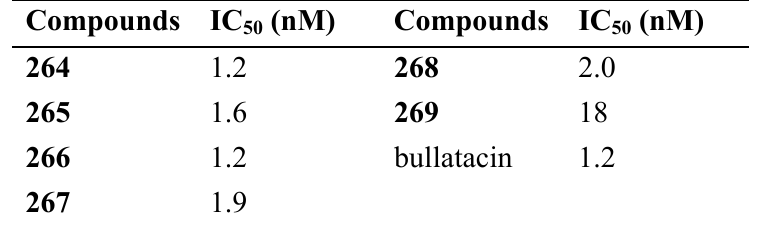
Table 20. Inhibition of complex